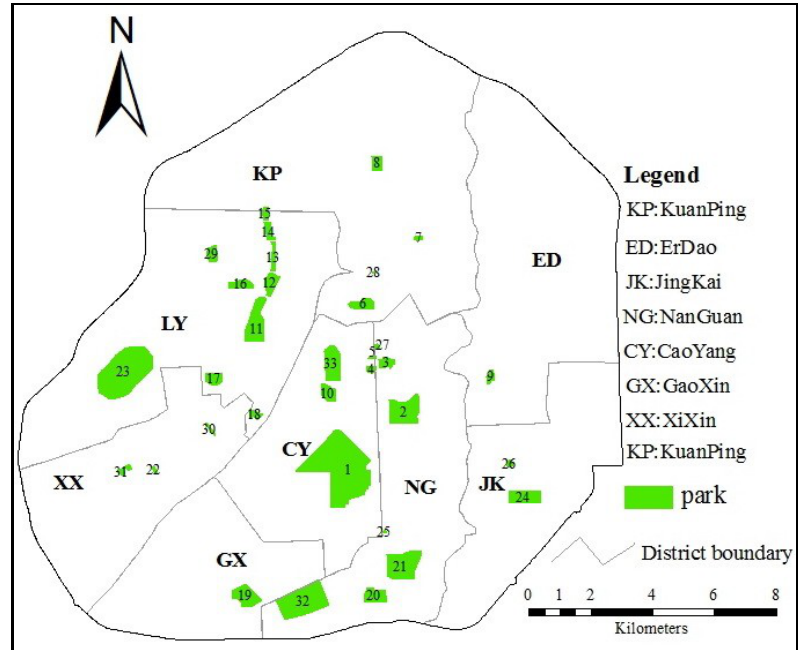
Figure 2. The selected parks of the study area in